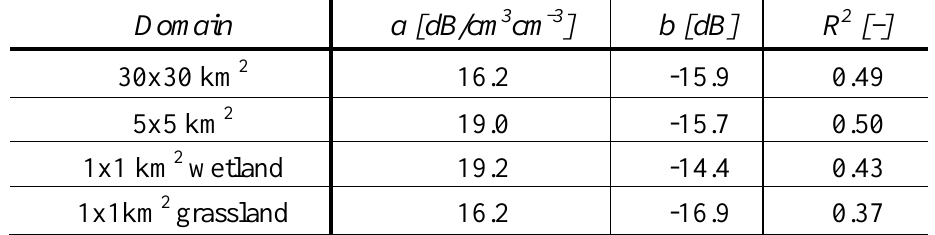
Table 1. Statistics related to linear regression functions computed between mean backscatter and soil moisture for the four spatial